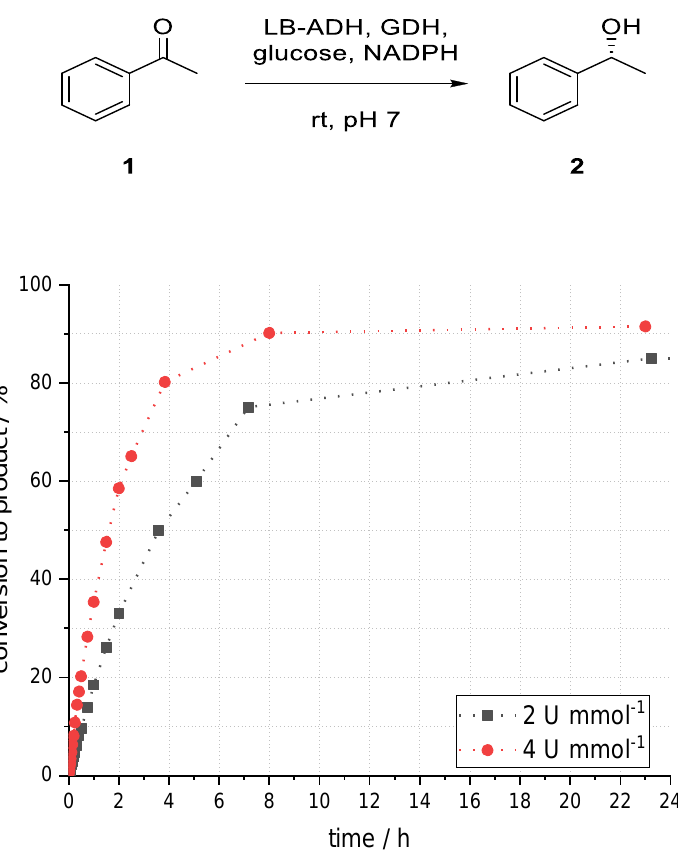
Figure 11. Influence of catalyst loading (in U mL − 1 ) on the conversion to phenylethanol ( R )- 2 in an enzymatic reduction of acetophenone ( 1 ) using ADH in superabsorber-immobilized aqueous phase.